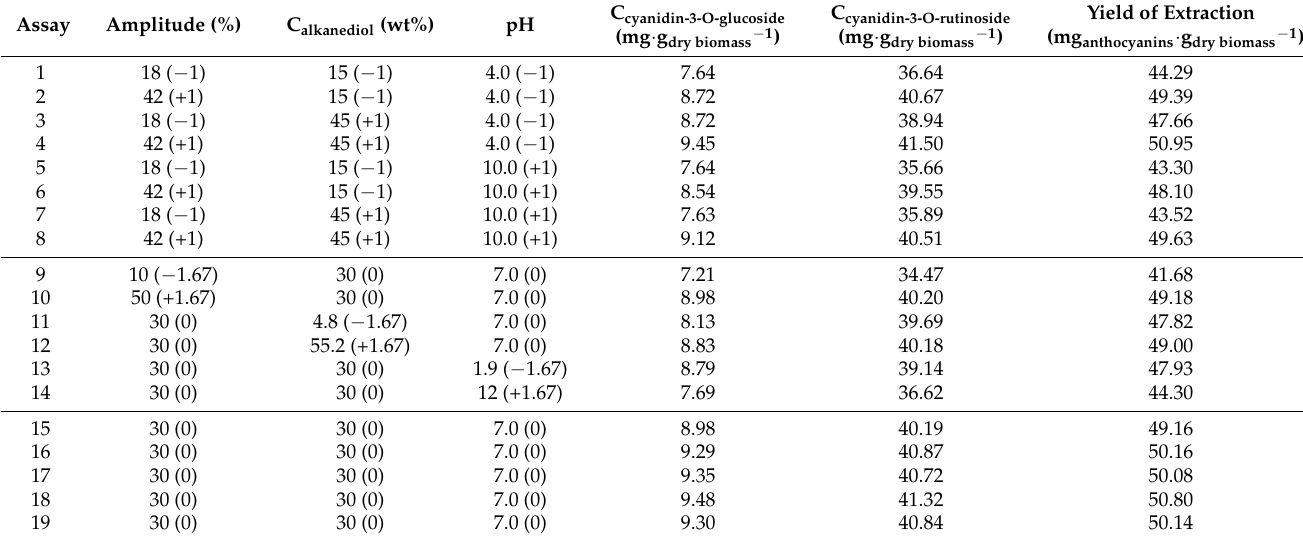
Table 2. Central composite rotatable design (CCRD) for the independent variables considered for the UAE extraction with aqueous solutions of 1,2-propanediol from juçara fruit samples at 10 min, and the results obtained for the extraction assays in terms of yield of extraction of